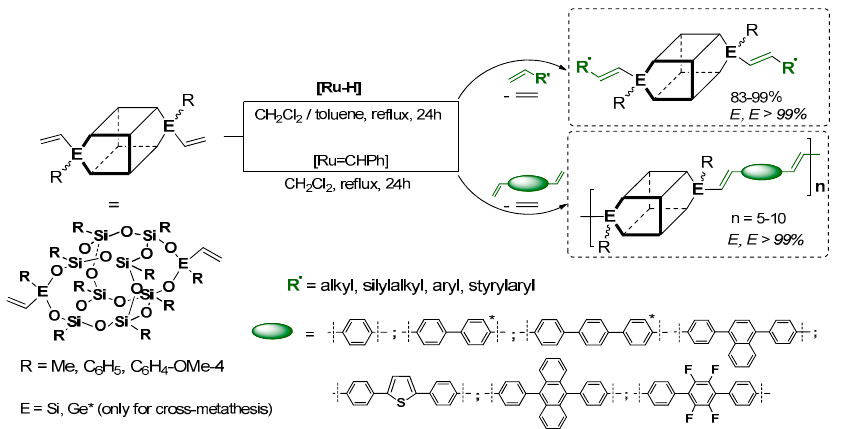
Figure 21. Synthetic protocol for stereoselective silylative coupling and cross-metathesis with olefins/dienes of divinyl-substituted DDSQ systems.